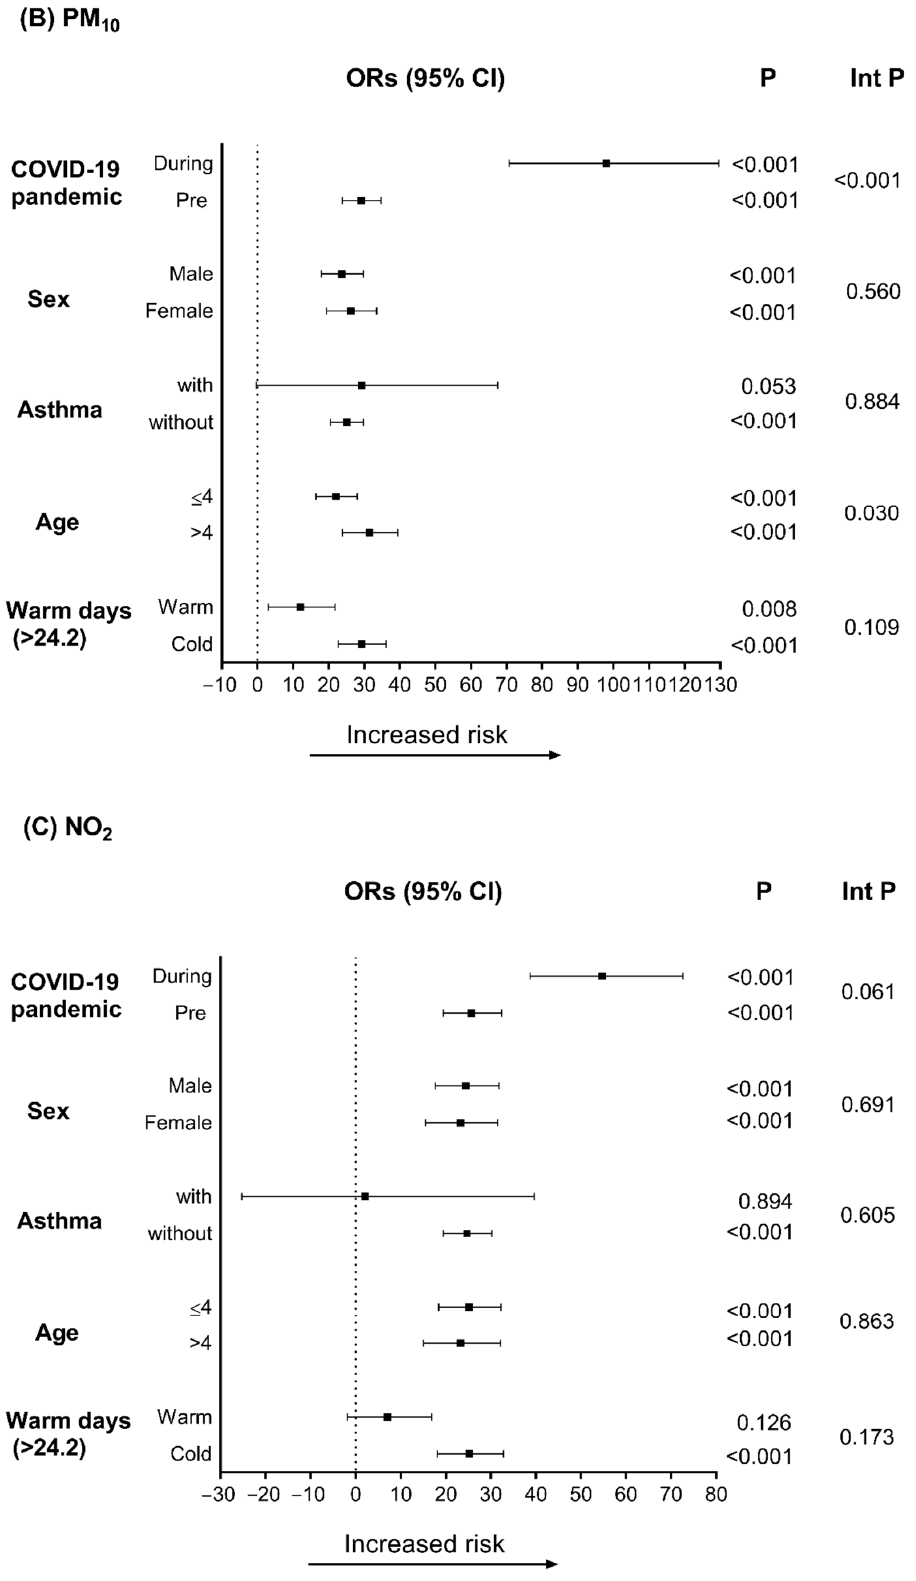
Figure 3. Odds ratios (ORs) for IQR increments in ( A ) PM 2.5 , ( B ) PM 10 , and ( C ) NO 2 on lag 1 after adjustment for temperature and humidity. Int p, interaction p